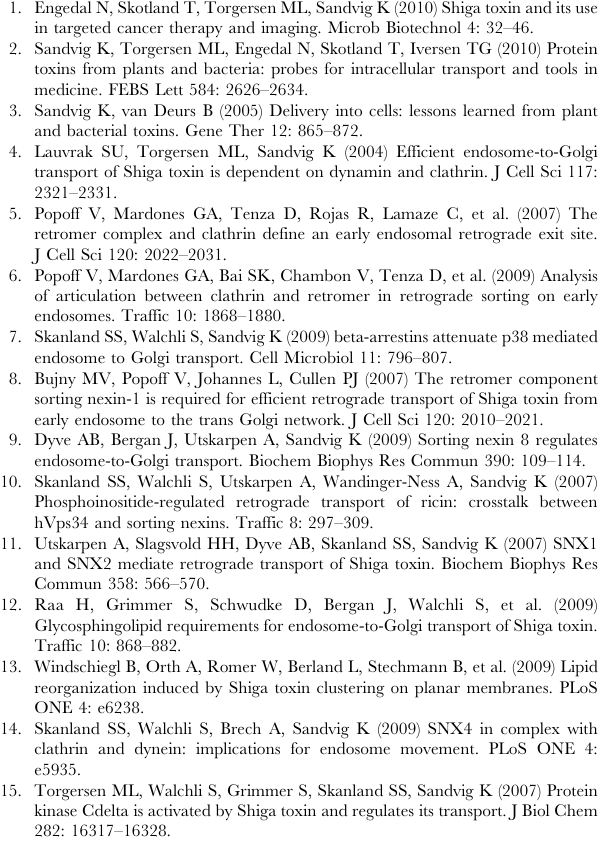
Figure S7 Absence of proximity for annexin A1 and GFP. Close proximity of annexin A1 with expressed GFP was evaluated using the proximity ligation assay from Duolink as described in the material and methods section. Fixed and permeabilized cells were incubated with the annexin A1 and GFP antibodies. Scale bar is 20 m m. The panel shows a representative GFP expressing cell with very few dots comparable to the surrounding untransfected cells.